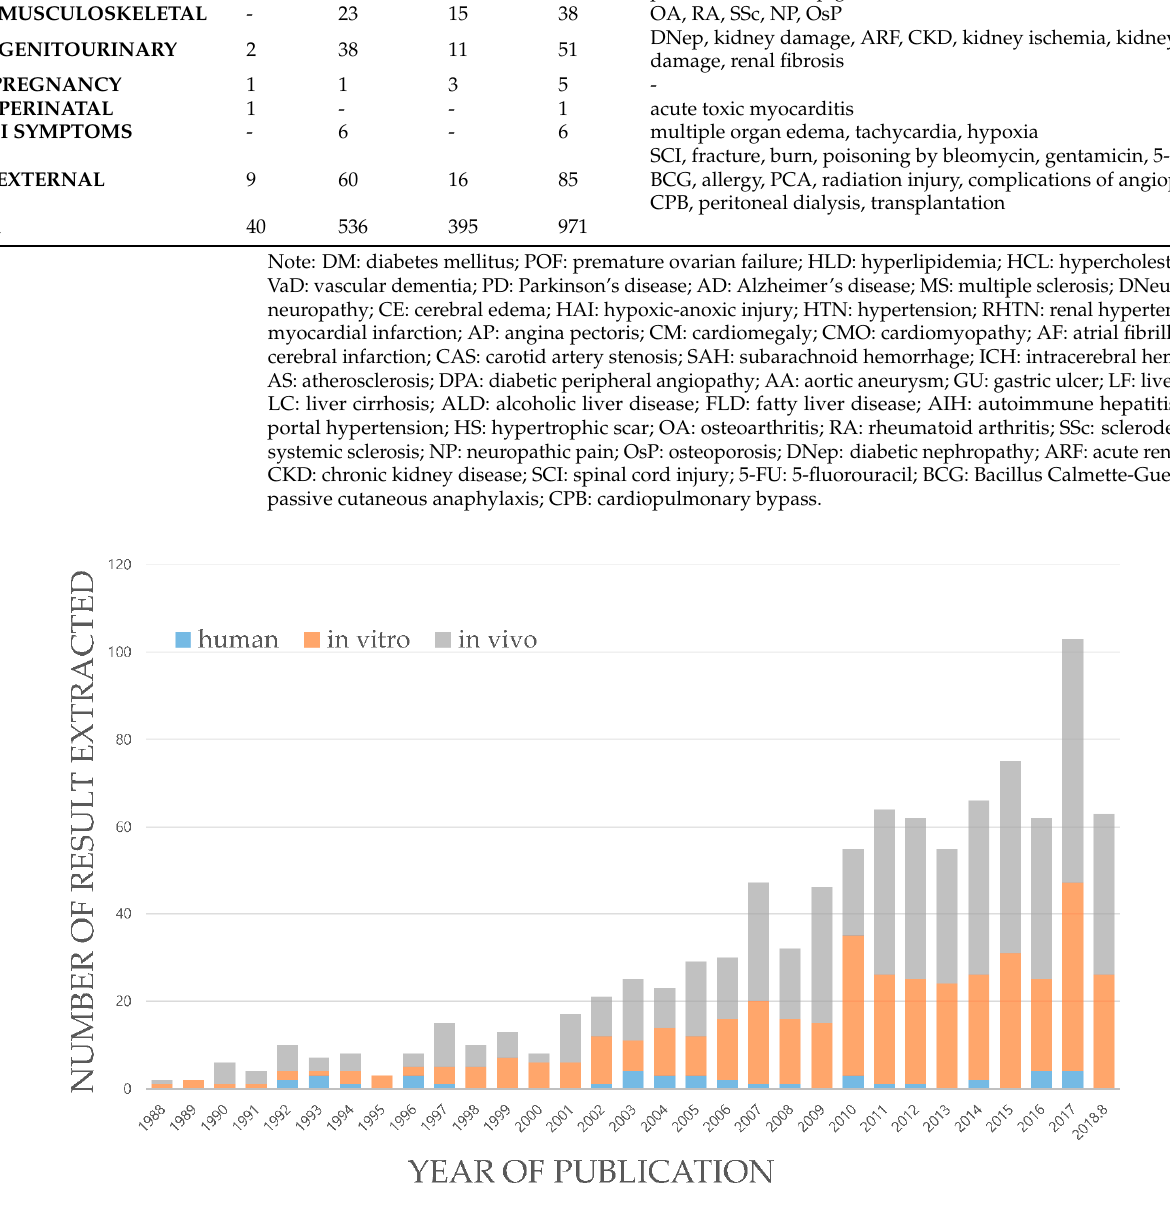
Figure 2. Number of extracted pharmacological results of SMC, published per year, from January 1988 to August 2018.